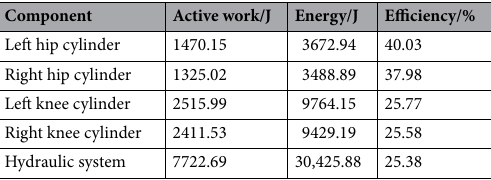
Table 5. Active work and energy consumption without optimization.